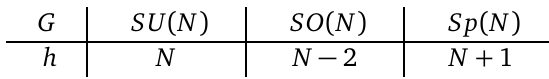
Table 1: Dual Coxeter number for classical groups.